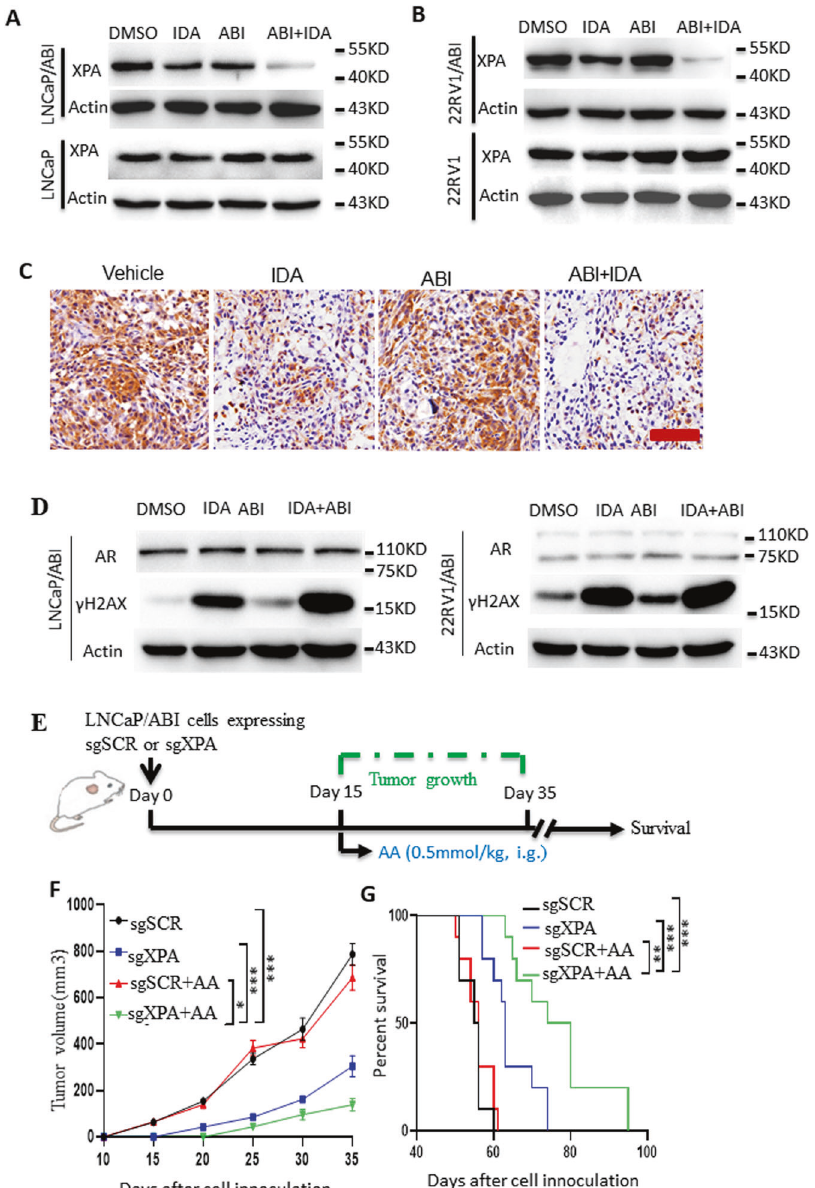
Fig. 3 XPA knockout combats the abiraterone resistance. A , B Abiraterone-resistant cells (LNCaP/ABI and 22RV1/ABI) and their parental control cells were treated with DMSO, ABI (10 μ M), IDA (0.25 μ M), and combination ABI with IDA. XPA expressions were determined by western blot. C XPA expression of tumor tissues from mice administered as shown in Fig. 2A was determined by IPC. Scale bar, 200 μ m. D LNCaP/ABI and 22RV1/ABI cells were treated with DMSO, ABI (10 μ M), IDA (0.25 μ M), and combination ABI with IDA. Expressions of γ H2AX and AR were determined by western blot. E – G LNCaP/ABI cells (1 × 10 6 ) were infected with lentivirus expressing sgSCR and sgXPA and then injected subcutaneously into the fl ank of 8-week-old male castrated mull mice. When tumor size reached about 50 mm 3 , mice were administered with vehicle (10% DMSO plus 90% corn oil mixture as control, n = 8), AA (0.5 mmol/kg, i.g.), ( n = 10, per group) ( E ). Tumor volume ( F ) and survival ( G ) were monitored as indicated days. Data are presented as means ± s.e.m. Statistical analysis for tumor growth and overall animal survival were performed using two-way ANOVA analysis ( F ) and Log-rank (Mantel-Cox) test analysis ( G ), respectively. The asterisks indicate signi fi cant differences between the indicated groups (* p < 0.05, *** p < 0.001). and ENZ treatment in LNCaP/ENZ (Fig. 5D) and 22RV1/ENZ IDA, ENZ, and a combination of IDA and ENZ, respectively. IDA (Fig. 5E) cells. IDA alone and in combination with ENZ treatment alone and combined with ENZ treatment displayed antitumor displayed no effect on AR expression in LNCaP/ENZ and 22RV1/ activity in LNCaP-bearing mice (Fig. S8). These data indicated that ENZ cells (Fig. 5D, E). These data indicate that IDA treatment IDA combats enzalutamide resistance. enhanced DNA damage in ENZ-resistant cells. We further assessed whether IDA affects AR expression and We next determined whether ubiquitination and autophagy DNA damage in enzalutamide-resistant prostate cancer cells and were involved in the IDA-induced decrease in XPA protein. their parental cell lines. Both IDA alone and in combination with Similarly, MG132 and CQ reversed the IDA-induced decrease in ENZ signi fi cantly decreased the expression of XPA and enhanced XPA protein levels in the presence of ENZ in LNCaP/ENZ and the expression of γ H2AX compared with that observed in DMSO Cell Death and Disease (2022)